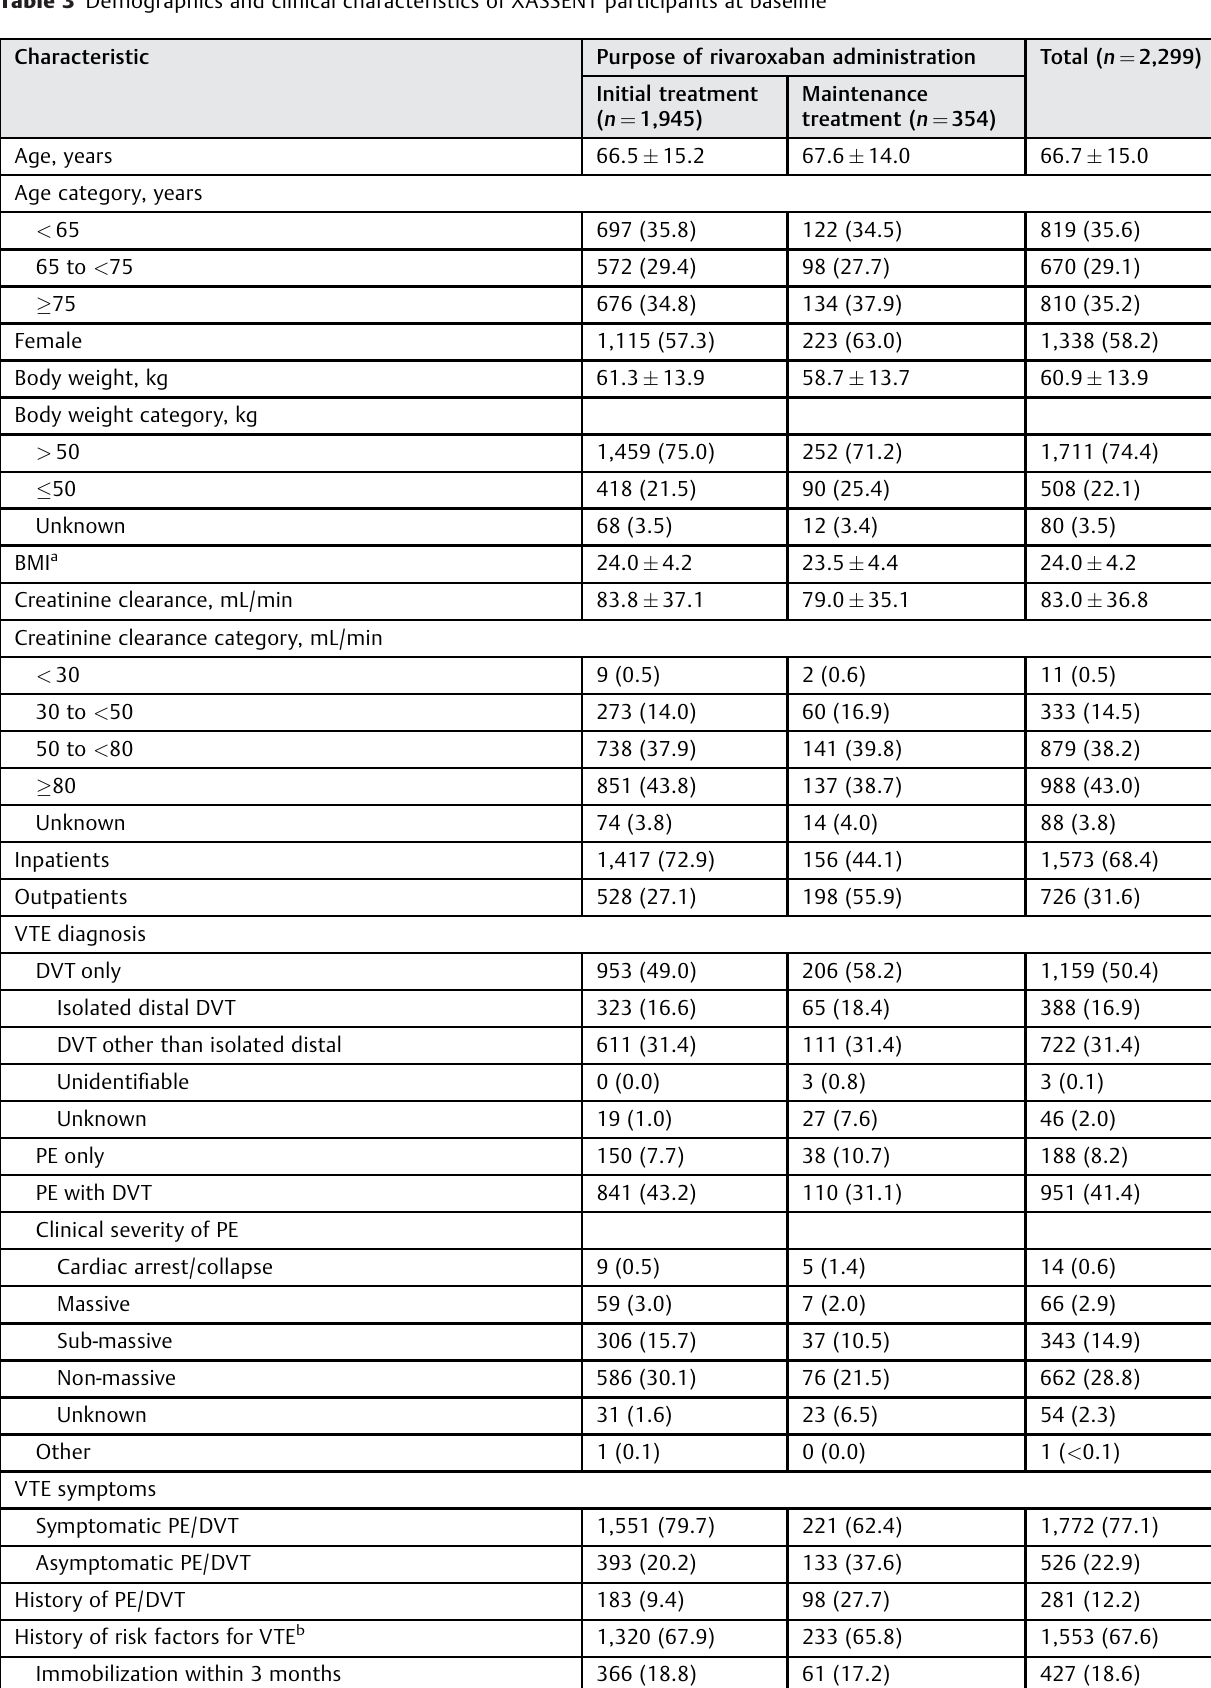
Table 3 Demographics and clinical characteristics of XASSENT participants at baseline